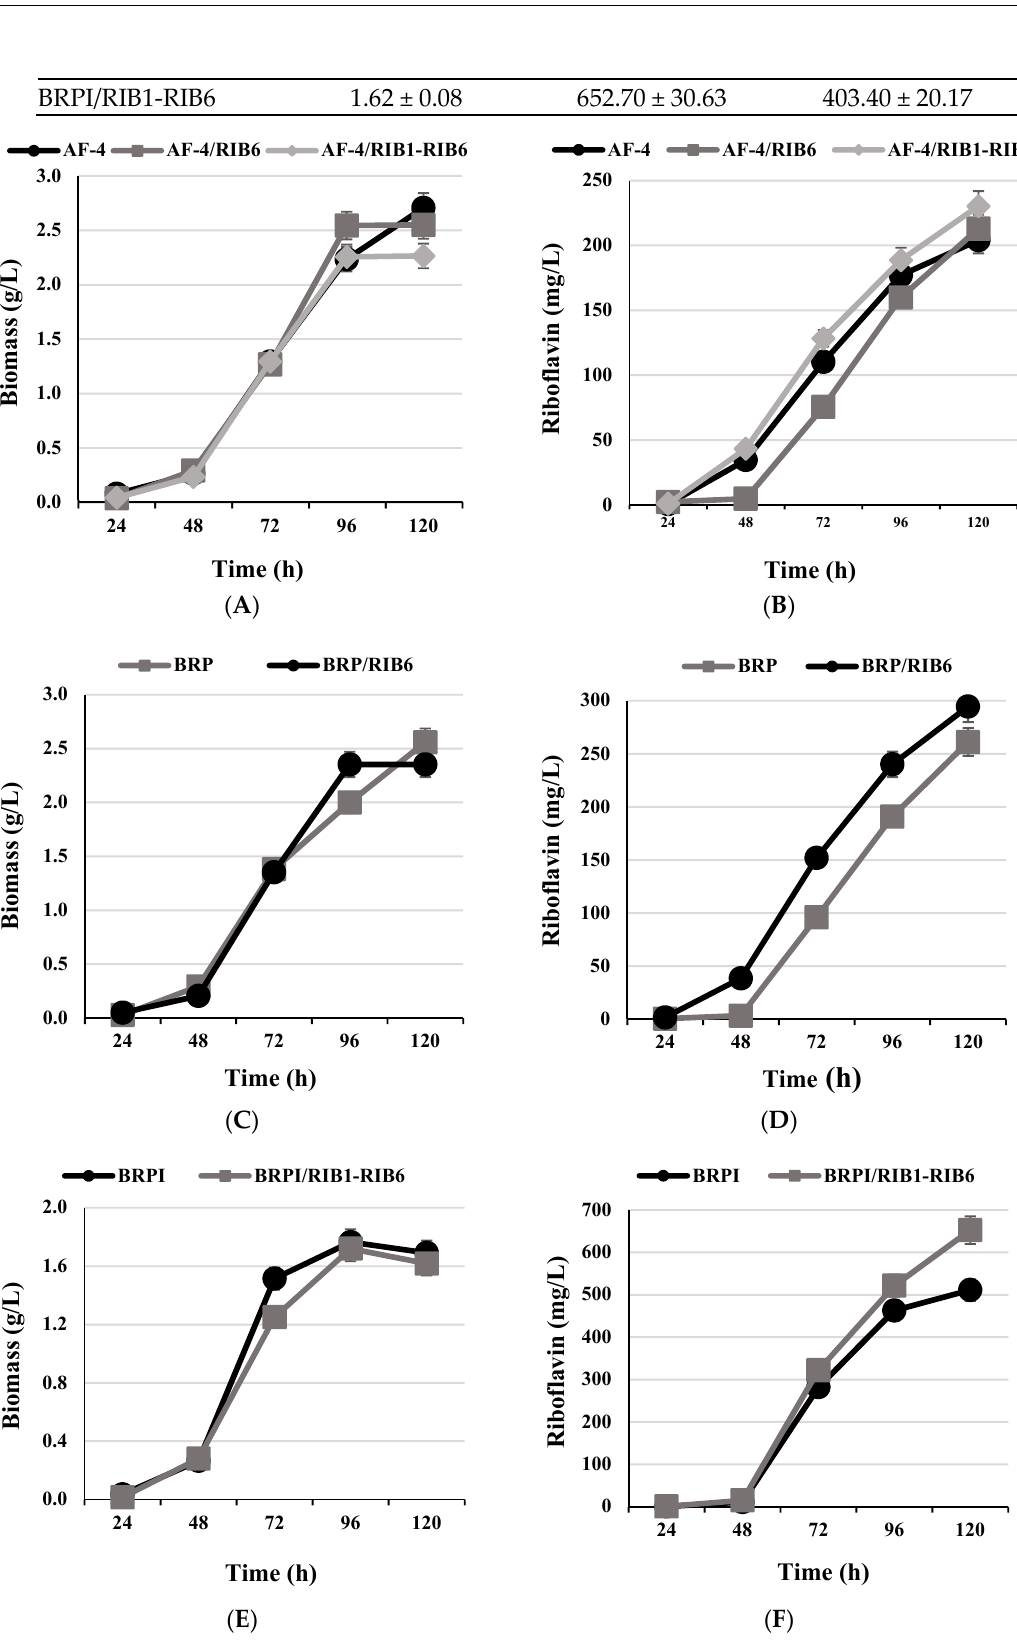
Figure 4. Time profiles of biomass accumulation ( A , C , E ) and riboflavin production ( B , D , F ) concen- tration by C. famata AF-4, AF-4/RIB6, AF-4/RIB1-RIB6, BRP, BRP/RIB6, BRPI, and BRPI/RIB1-RIB6 on YNB medium in flasks.